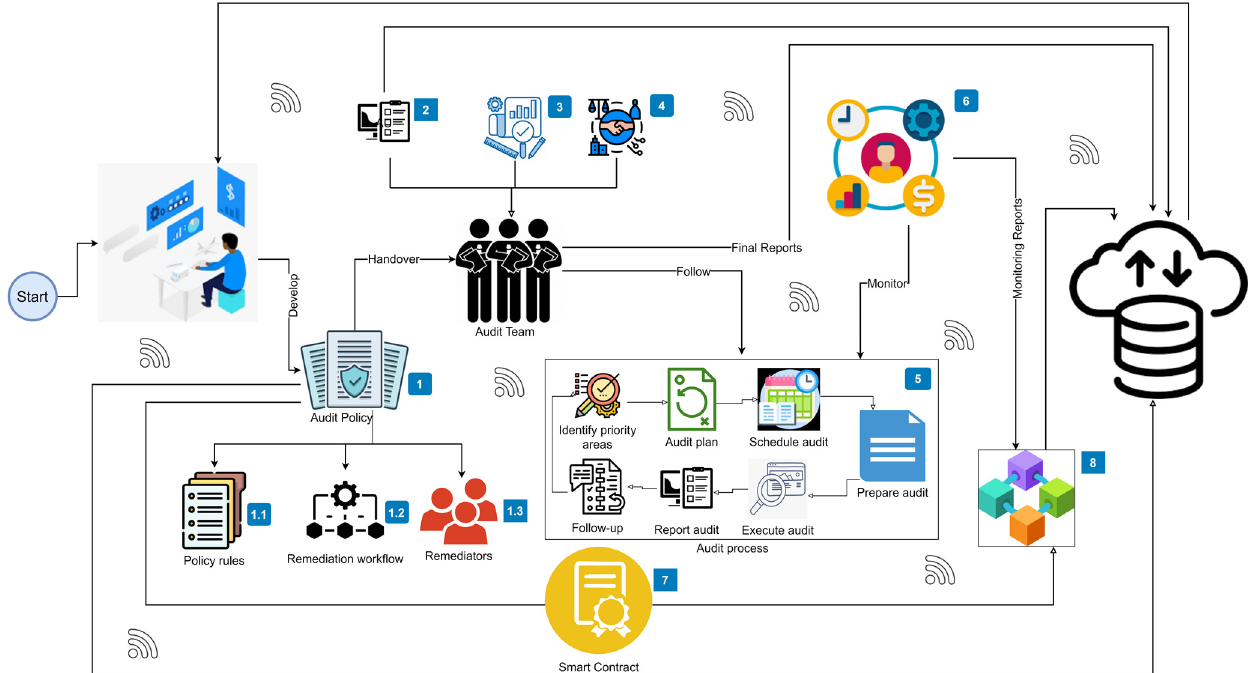
Figure 3. SSFTA: a smart and secure framework for transparent software auditing .